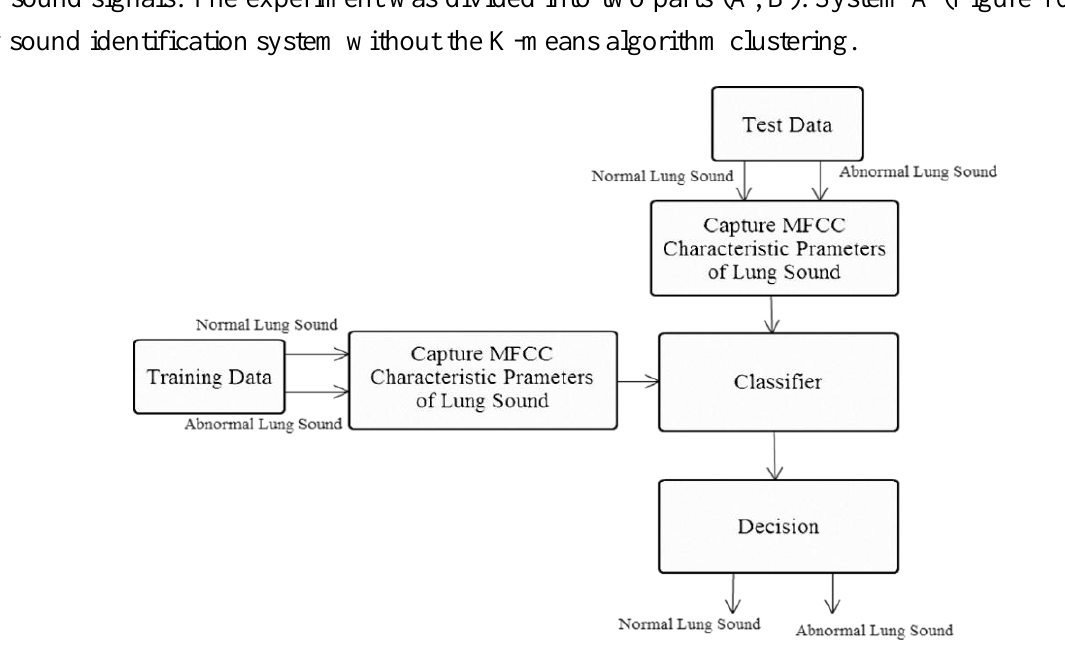
Figure 16. System A: Lung sound identification